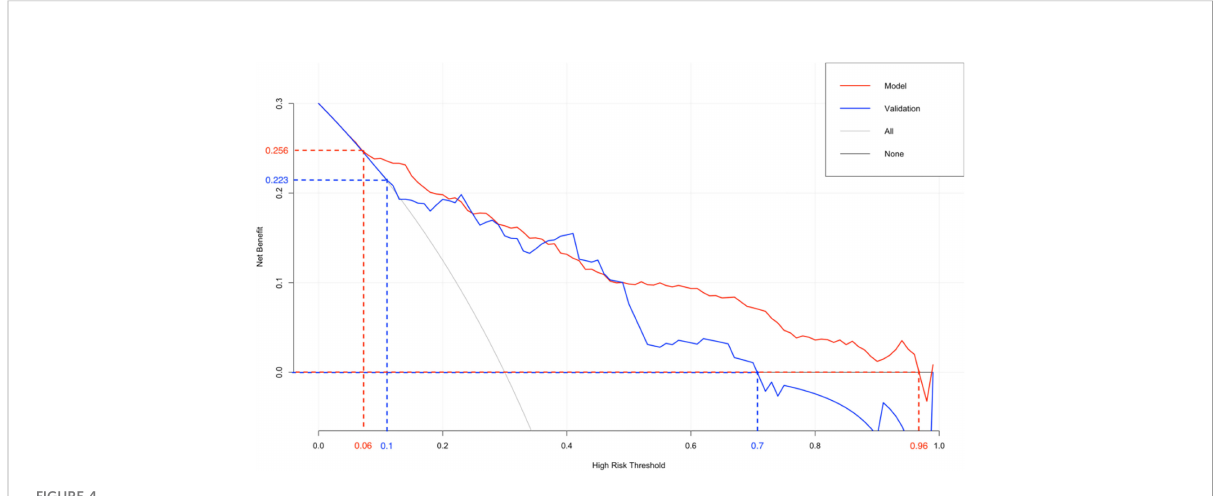
FIGURE 4 Decision curve